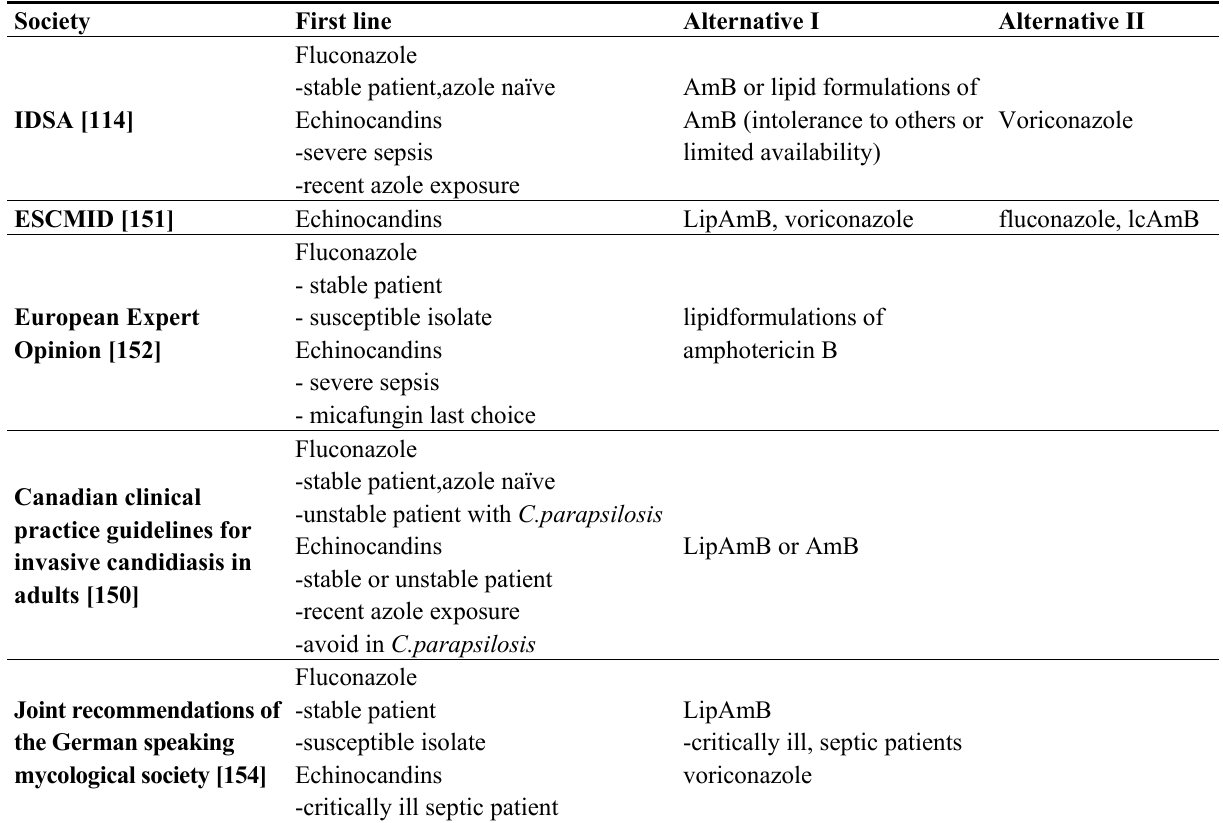
Table 7. Suggested treatment of documented candidaemia/invasive candidiasis in non- neutropenic patients according to different guidelines.